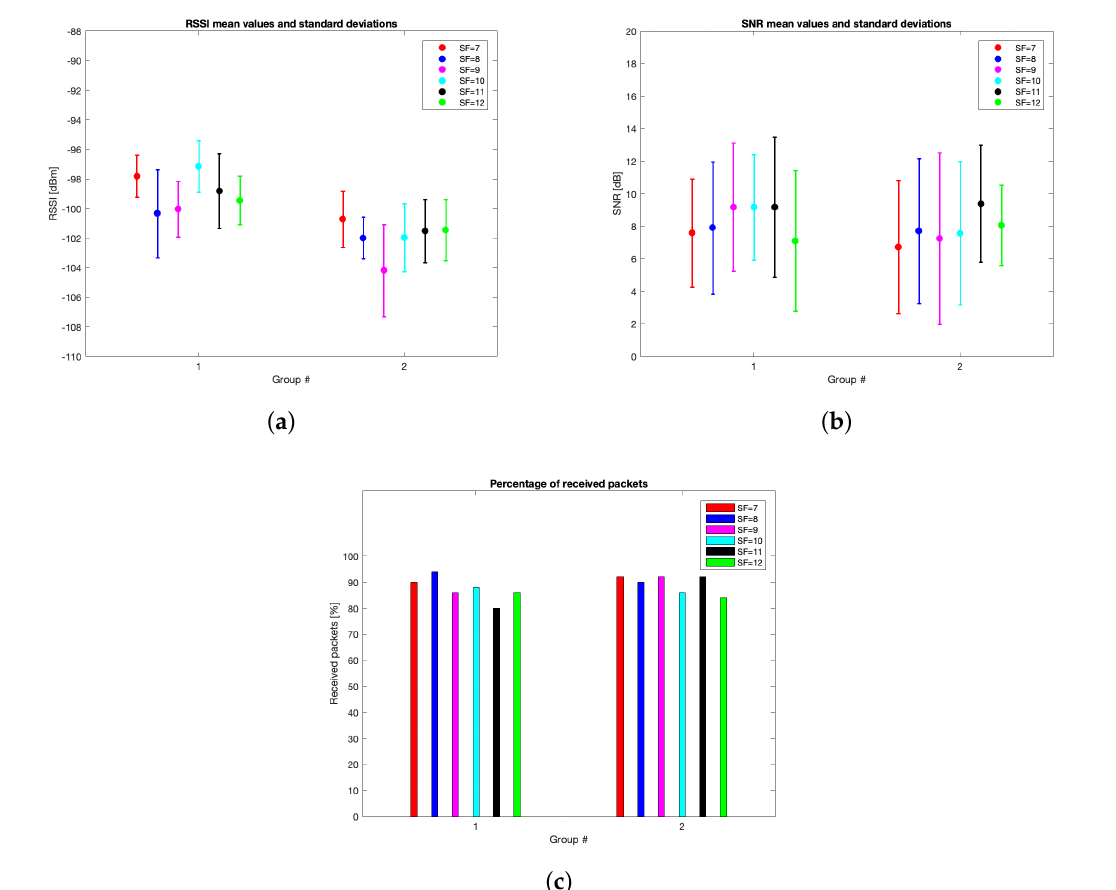
Figure 18. Group comparison graphical analysis divided by SFs: ( a ) RSSIs mean values and standard deviations; ( b ) SNRs mean values and standard deviations; ( c ) percentage of received